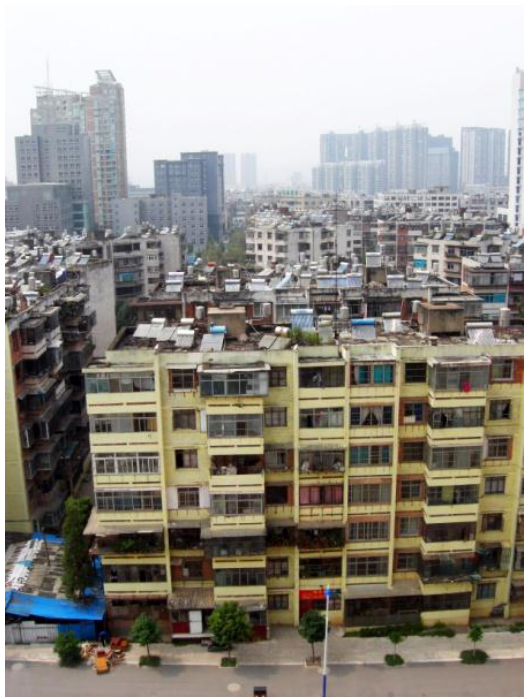
Figure 10. Solar hot water systems on roofs of residential